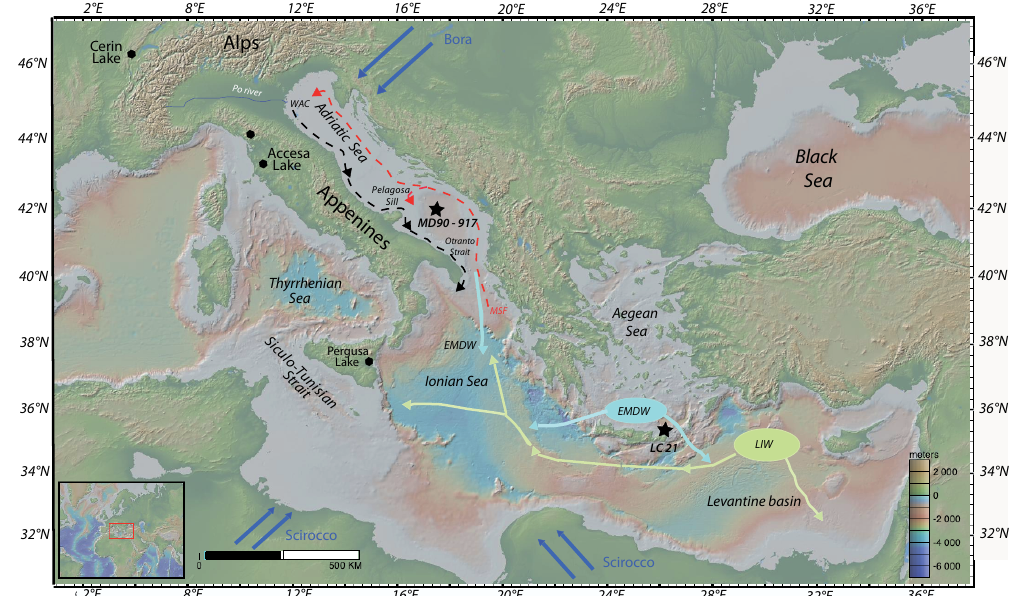
Fig. 1. Location of the studied core MD90-917 and reference sites in the Mediterranean and north of the Alps. Core LC-21 (Rohling et al., 2002; Marino et al., 2009), Cerin Lake (Magny et al., 2011a), Accesa Lake (Magny et al., 2007), Pergusa Lake (Magny et al., 2012a). Blue arrows correspond to the main low-level winds (Bora and Scirocco). LIW = Levantine Intermediate water, EMDW = Eastern Mediterranean Deep Water, MSF = Mediterranean Surface Water, WAC = Western Adriatic